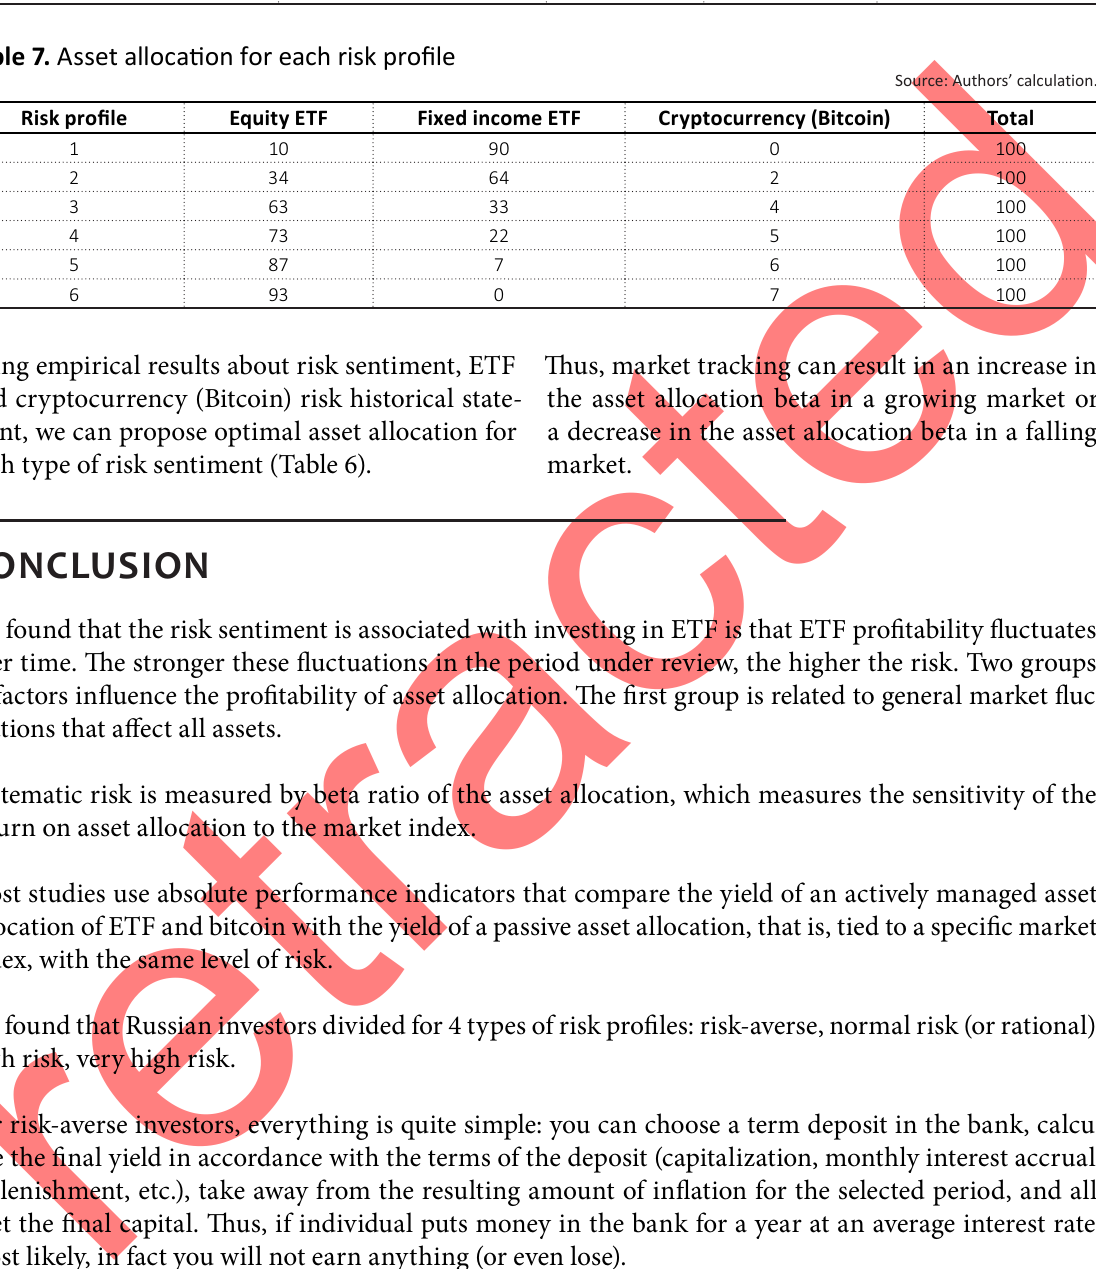
Table 6. Asse t allocation for each risk profile